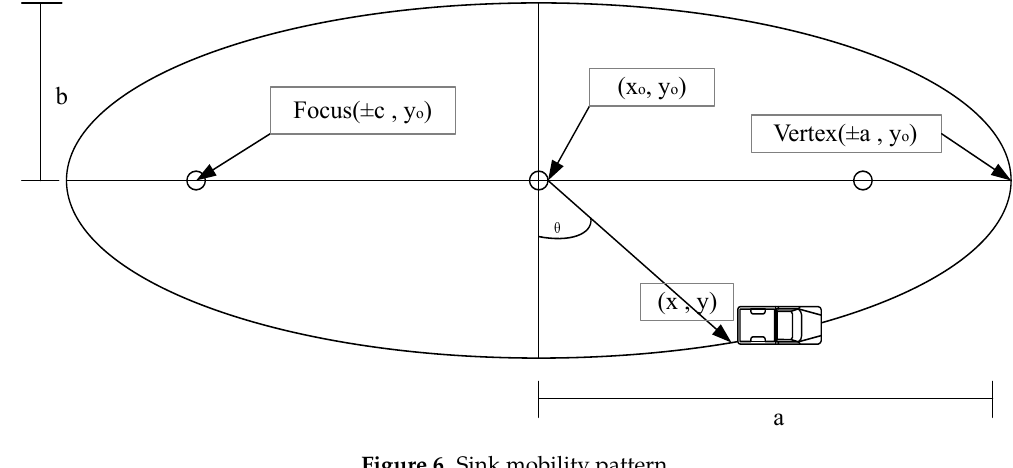
Figure 6. Sink mobility